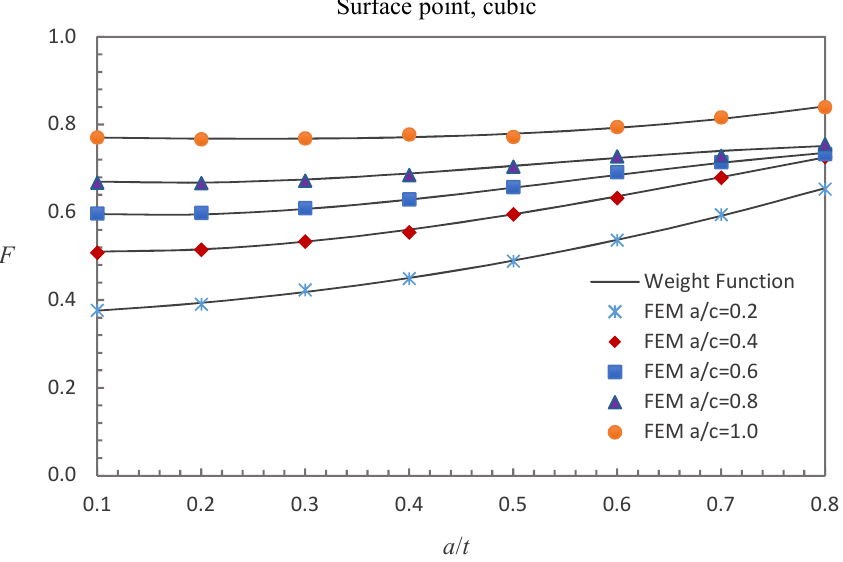
Figure 8. Comparison of weight function and FE results in this study with cubic stress distribution (surface point).